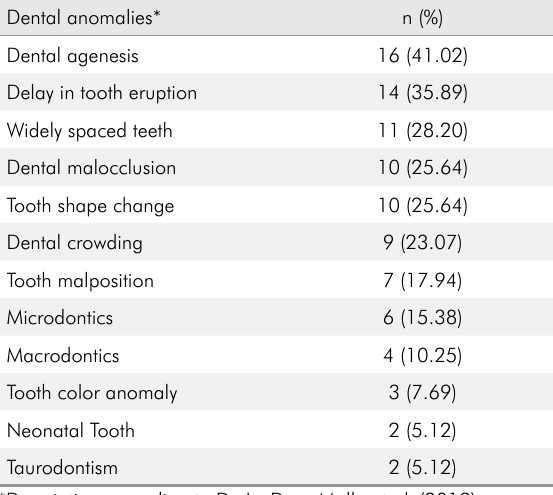
Table 2. Frequency of the dental anomalies in syndromes